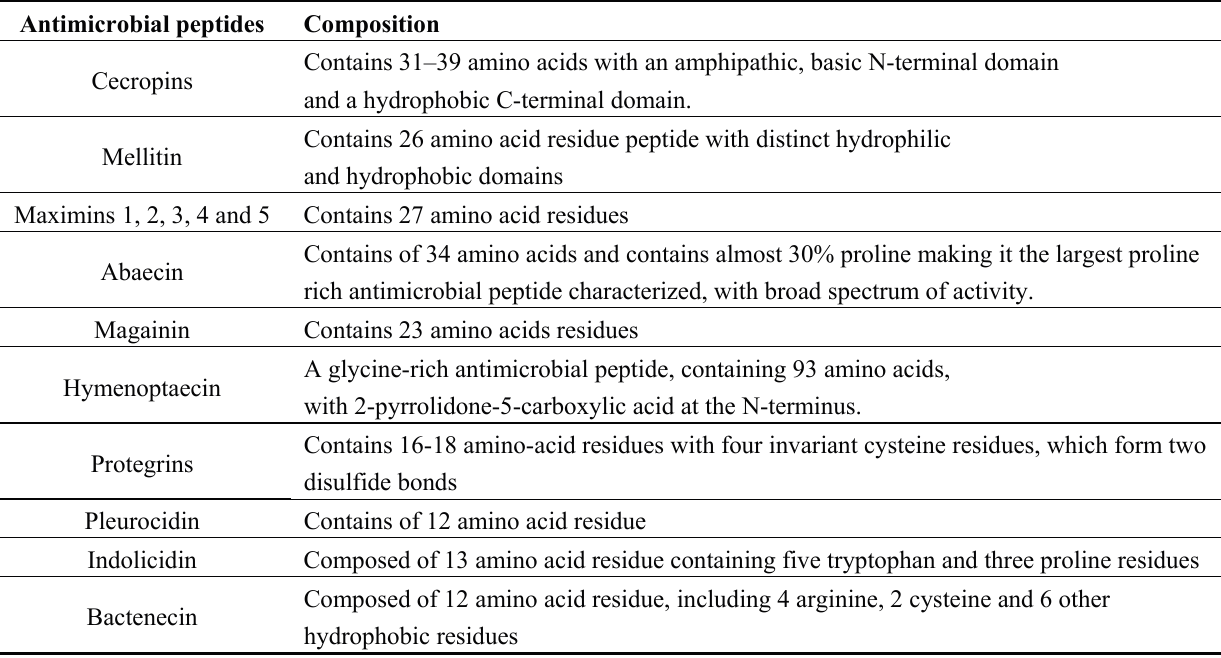
Table 1. Examples of AMPs and their composition (adapted from Oyinloye et al. [19]). Antimicrobial